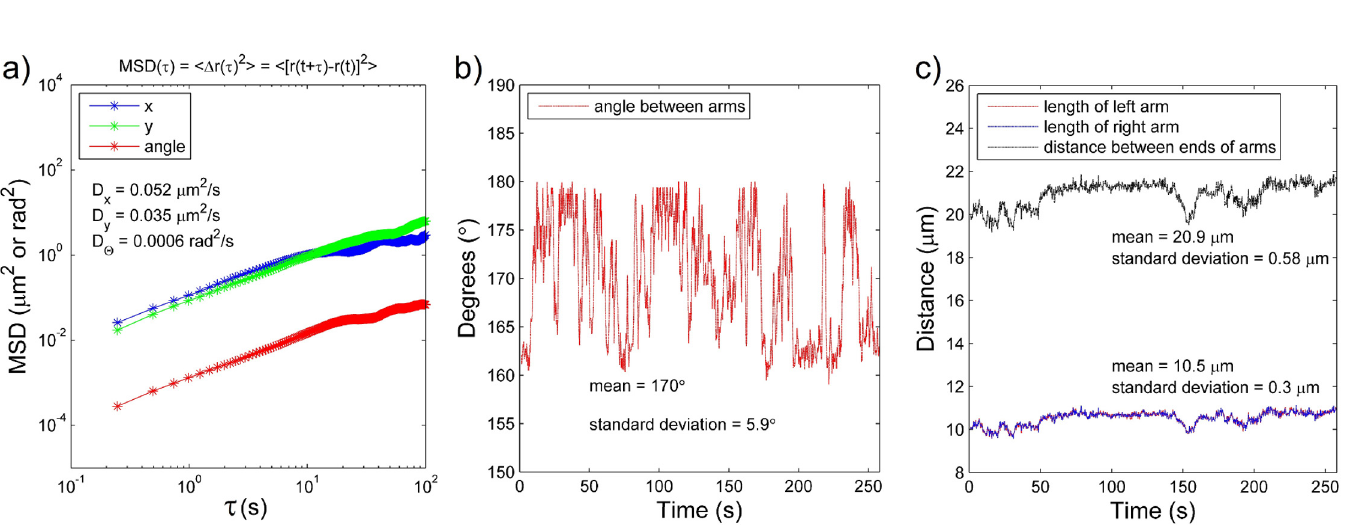
Fig 7. a) Plot of the mean square displacement of a filament of contour length 21.5 μ m as a function of lag time. The upper two plots are MSDs along the a and b axes in terms of μ m 2 , whereas the bottom one is the angular MSD in terms of mrad 2 . b) Angle between arms of the bending filament as a function of time. c) Length of left and right arm of the bending filament, and distance between both ends of the arms. All plots present calculations for the nanofilament No. 1 from Table 1.